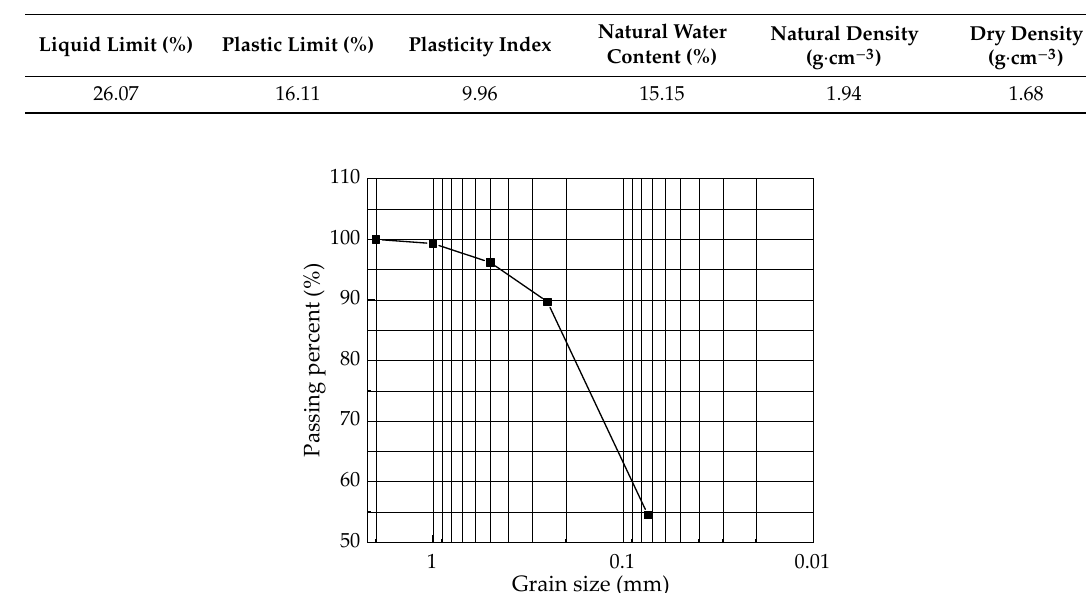
Figure 1. Site of soil sampling.